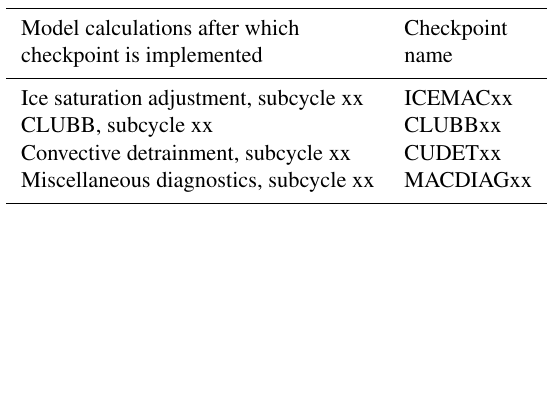
Table B3. Checkpoints implemented in the “clubb_tend_cam” sub- routine. The order of checkpoints in the table is the same as the actual order of the checkpoints in the